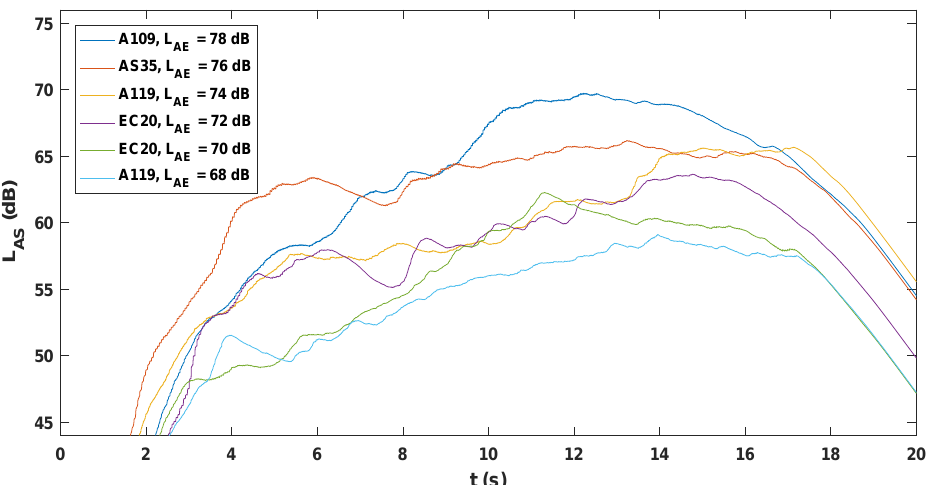
Figure 3. L AS,F as a function of time for the six flight events (no added background sounds) used in experiment 1. Helicopter type and L AE,F of each individual flight event is indicated in the